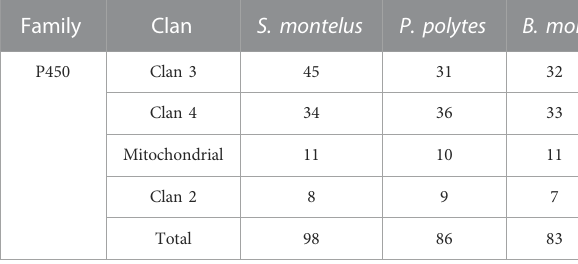
TABLE 5 Comparison of cytochrome P450 subgene families between S. montelus and Bombyx mori . Family Clan S. montelus P.